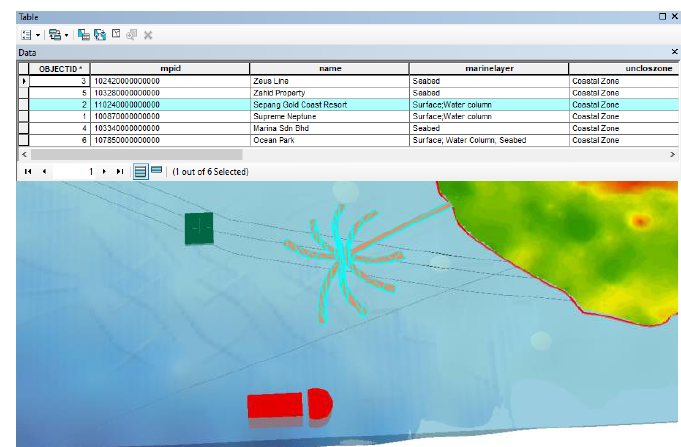
Figure 5. Simple query in